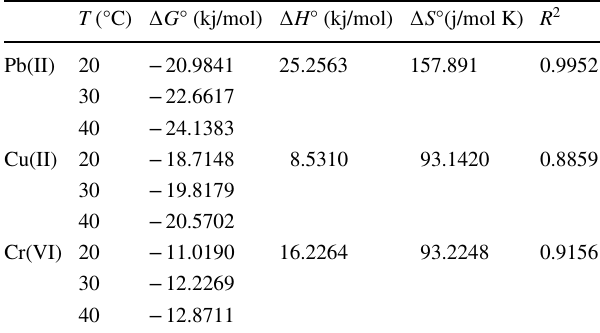
Table 6 Calculated thermodynamic parameters for heavy